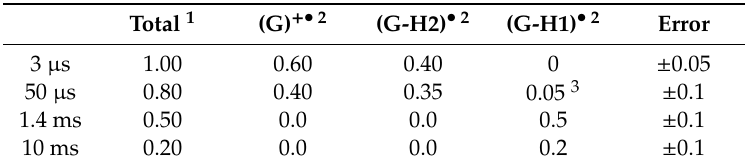
Table 2. Evolution of guanine radical populations in TEL21 / K + , expressed as molar fractions of the initially generated radical concentration [R] 0 = [e hyd − ] 0 . Figure 5. Survival probability P t of the total G radical population in TEL21/K + , estimated by the transient absorption signals at 512 nm, recorded on the microsecond ( a ) and the millisecond ( b ) time- scales. Red lines correspond to fits with bi-exponential functions. 1 from the decays at 512 nm (Figure 8); 2 from reconstruction of the time-resolved spectra (Figure 6); 3 from the rise in Figure